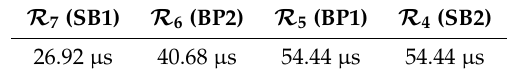
Table 5. T1-1 system message scheduling analysis